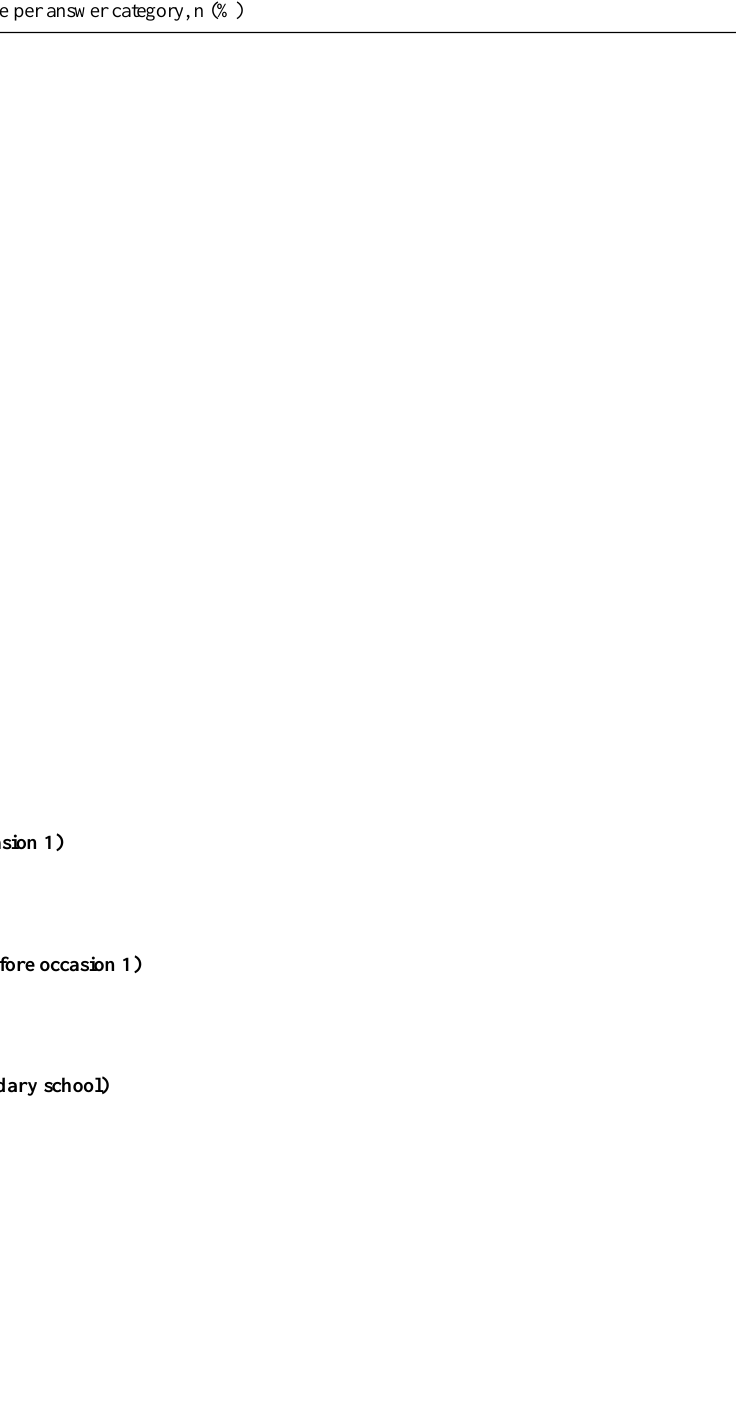
Table 3. Demographic and clinical characteristics for the overall sample